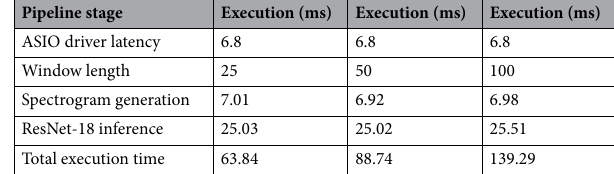
Table 2. Pipeline execution times.